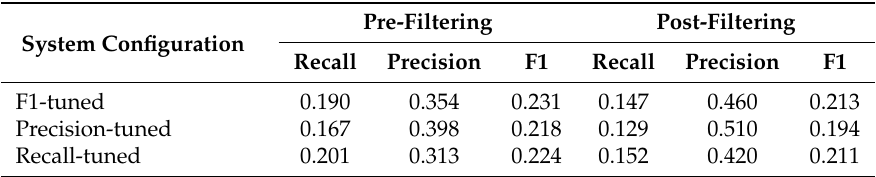
Table 10. Average global evaluation for all systems using the TAC KBP 2013 Slot Filling scorer on the test dataset before and after filtering for F1, precision and recall oriented runs.